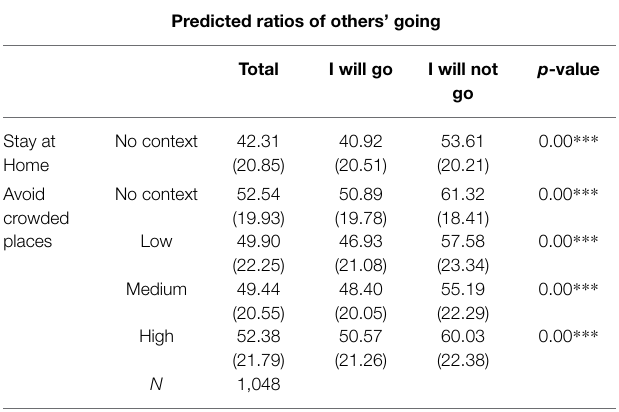
TABLE 4 | Statistical testing of the difference between conditions: going versus not